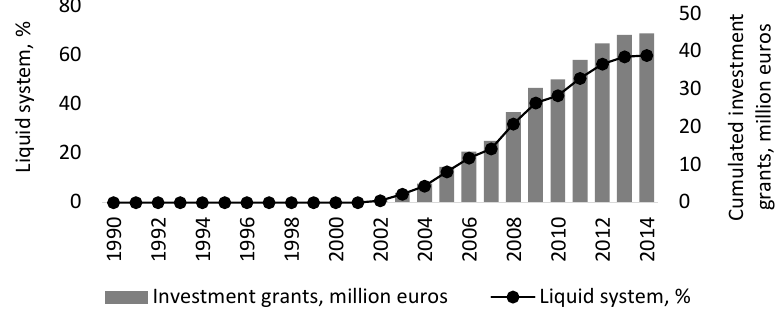
Fig. 3. Share of liquid systems in manure management and cumulated investment